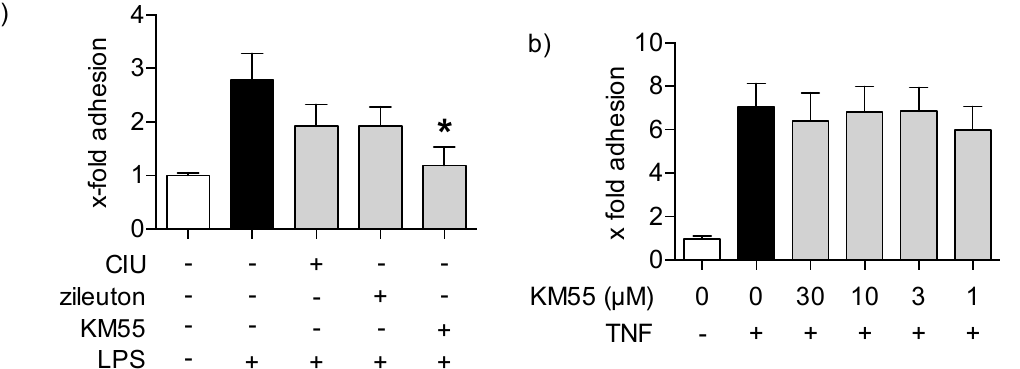
Figure 3. KM55 blocks leukocyte-endothelial cell interaction by impairing leukocyte activation, whereas endothelial cells are not affected. ( a ) The adhesion of monocyte-like THP-1 cells onto HUVECs is significantly reduced by 30 µ M KM55 (* p < 0.05 vs. LPS alone). THP-1 cells where pretreated with CUI (10 µ M), zileuton (10 µ M) or KM55 (30 µ M, each) for 30 min and were then activated with 1 µ g/mL LPS for 24 h; ( b ) HUVECs were pretreated with 30 µ M KM55 for 30 min before they were activated with 10 ng/mL TNF- α for 24 h. THP-1 cells were left untreated. Adhesion assays were performed as described in the section Materials and Methods. Data are expressed as mean ±